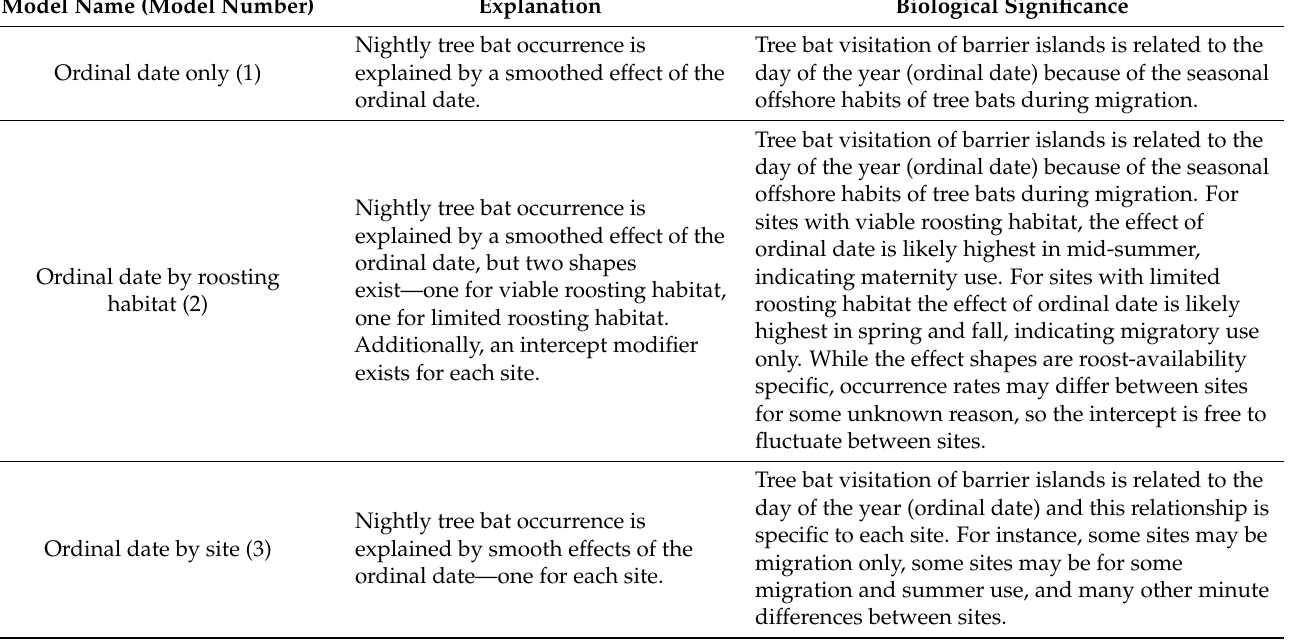
Table 1. A priori generalized additive models to evaluate the shape of the effect of seasonality (ordinal date) of tree bat occurrence at offshore/barrier island sites, Eastern Shore of Virginia, USA, 2012–2019. Three models are presented—one that only considers the ordinal date, one that considers local roosting availability, and one that considers site specifics. Model Name (Model